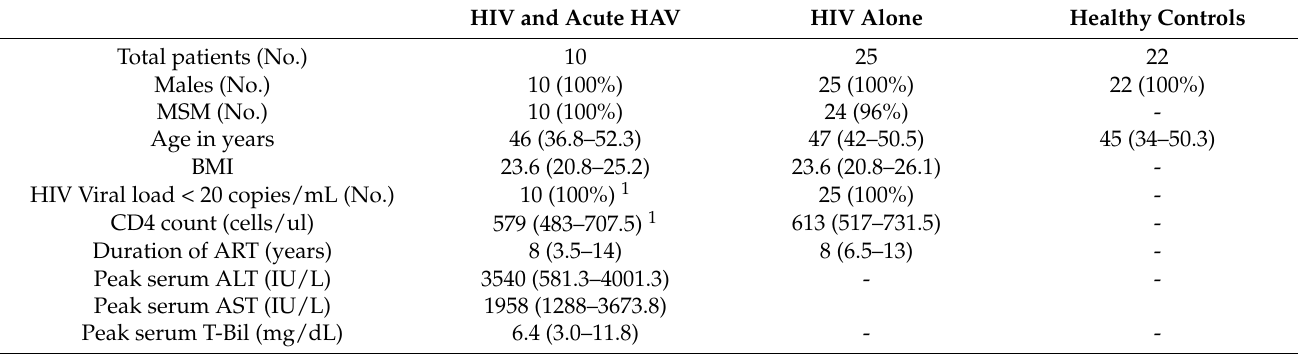
Table 3, the values of liver markers (AST, ALT, and T-Bil) and antibody levels (HA-IgM) during HAV infection were shown. Table 1. Comparison of the characteristics among HIV patients with or without hepatitis A and healthy controls. HIV and Acute HAV HIV Alone Healthy